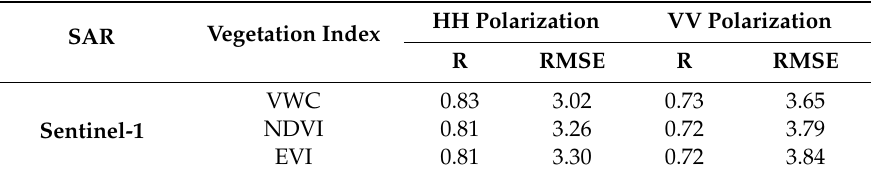
Table 3. Fitting result of backscattering coe ffi